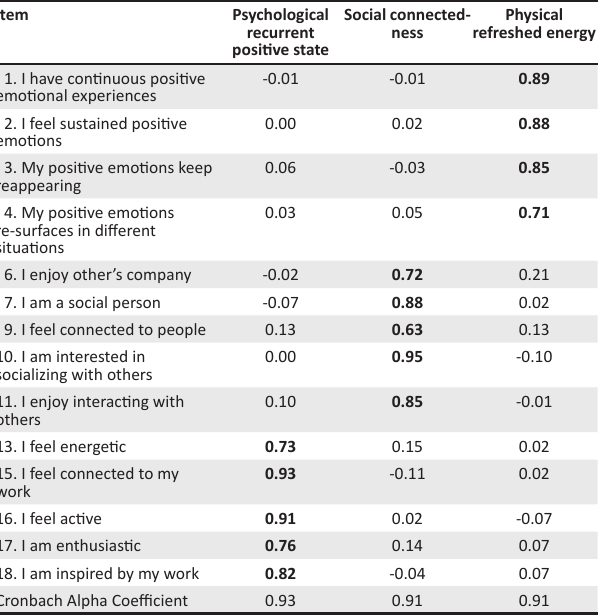
TABLE 5: Principal Axis Direct Oblimin Oblique Rotation, polychoric correlation, for the three-factor solution of the Positive Emotional Experiences Scale. Item